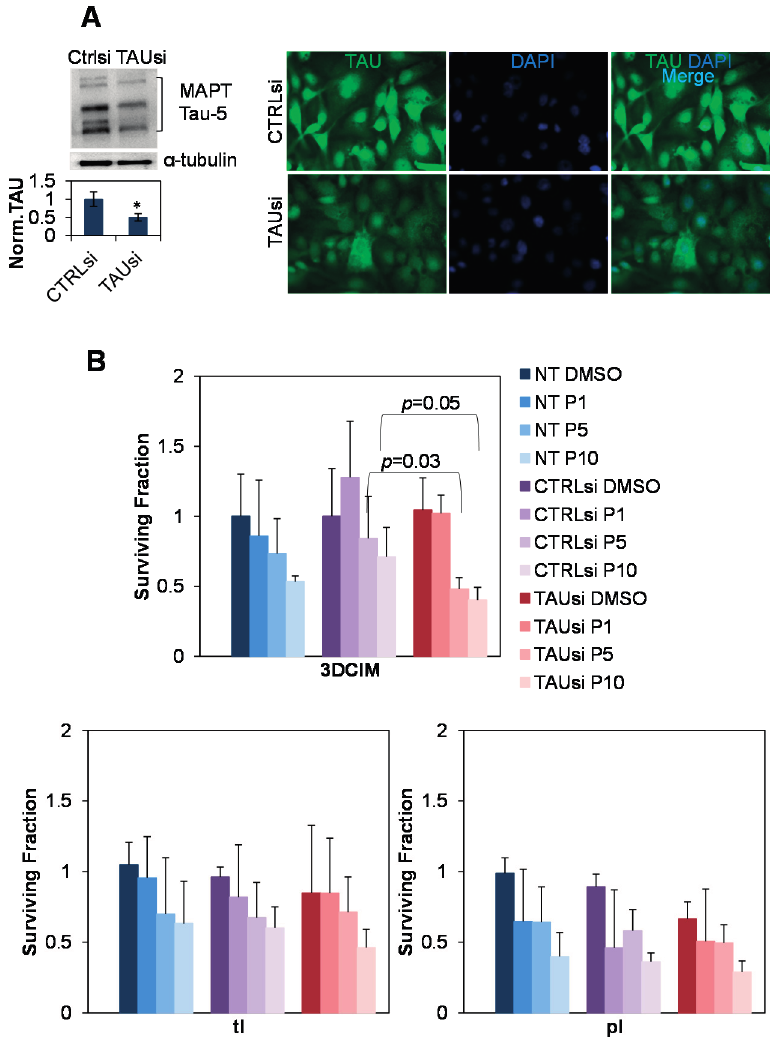
Figure 3. Down-regulation of tau reduces clonogenic ability of SKOV-3 cultured atop three-dimensional collagen type I matrix. ( A ) Cells were transiently transfected with either control (CTRLsi) or tau-specific (TAUsi) siRNAs for three days followed by detection of Tau expression using Western blot and immunofluorescence staining. Down-regulation of tau was quantified using Western blot and digital densitometry ( right panel ). Normalized tau was quantified by dividing intensity values corresponding to all tau isoforms by those corresponding to α -tubulin. α -Tubulin was used as a loading control. *, p < 0.05; Student’s t -test. Loss of both nuclear and cytoplasmic tau after silencing with tau-specific siRNAs was visualized using immunofluorescence staining with anti-tau antibodies ( left panel ). Images were generated using a Zeiss fluorescence microscope and 20× objective lens. The fluorescence signal from tau staining (green) was overlaid with DAPI staining (blue) to generate a merged image; ( B ) Cells were transiently transfected with either control (CTRLsi) or Tau-specific (TAUsi) siRNA, or non-transfected (NT) for three days, then replated atop three-dimensional collagen type I matrix (3DCIM), thin lay er coated collagen type I (tl), and plastic supports (pl), treated with paclitaxel at 1, 5, and 10 nM (designated P1, P5, and P10, respectively) or DMSO as a control for 24 h followed by clonogenic assay as indicated in the